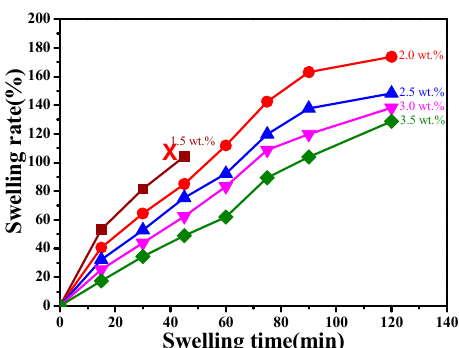
Figure 4. The swelling rate curves of CaAlg hydrogel membranes prepared with different NaAlg concentrations. Copper wire diameter: 0.3 mm (NaAlg concentrations: dark red line: 1.5 wt.%; red line: 2.0 wt.%; blue line: 2.5 wt.%; purple line: 3.0 wt.%; green black: 3.5 wt.%). 3.4. BSA Rebinding of MIP and NIP Hydrogel Prepared under Different pH Values of BSA